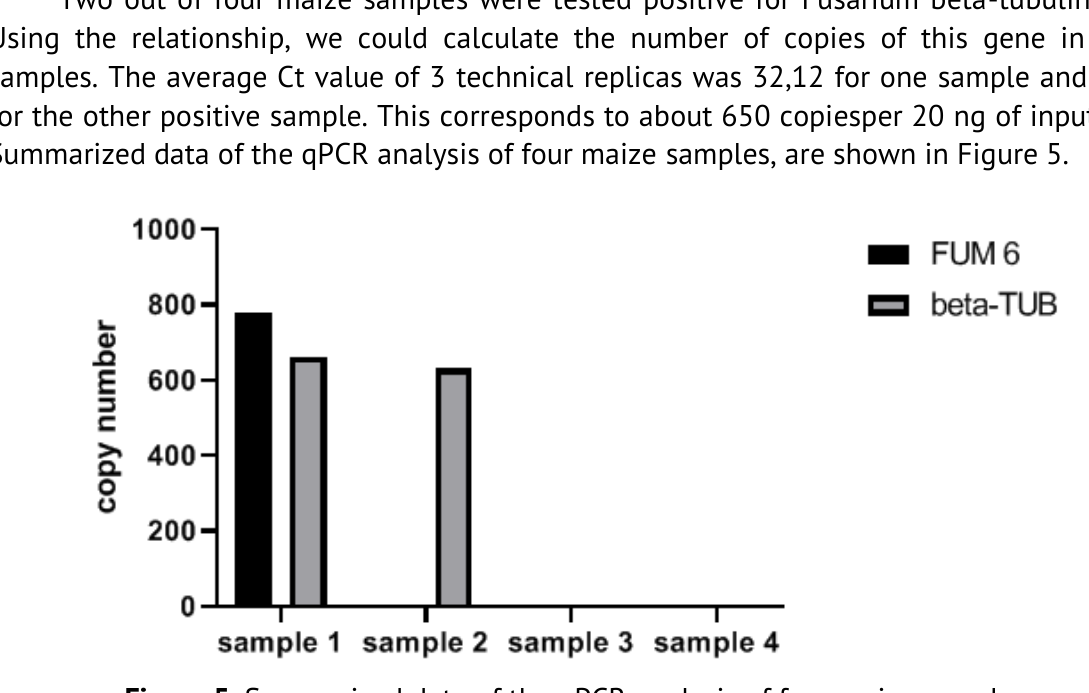
Figure 5 . Summarized data of the qPCR analysis of four maize